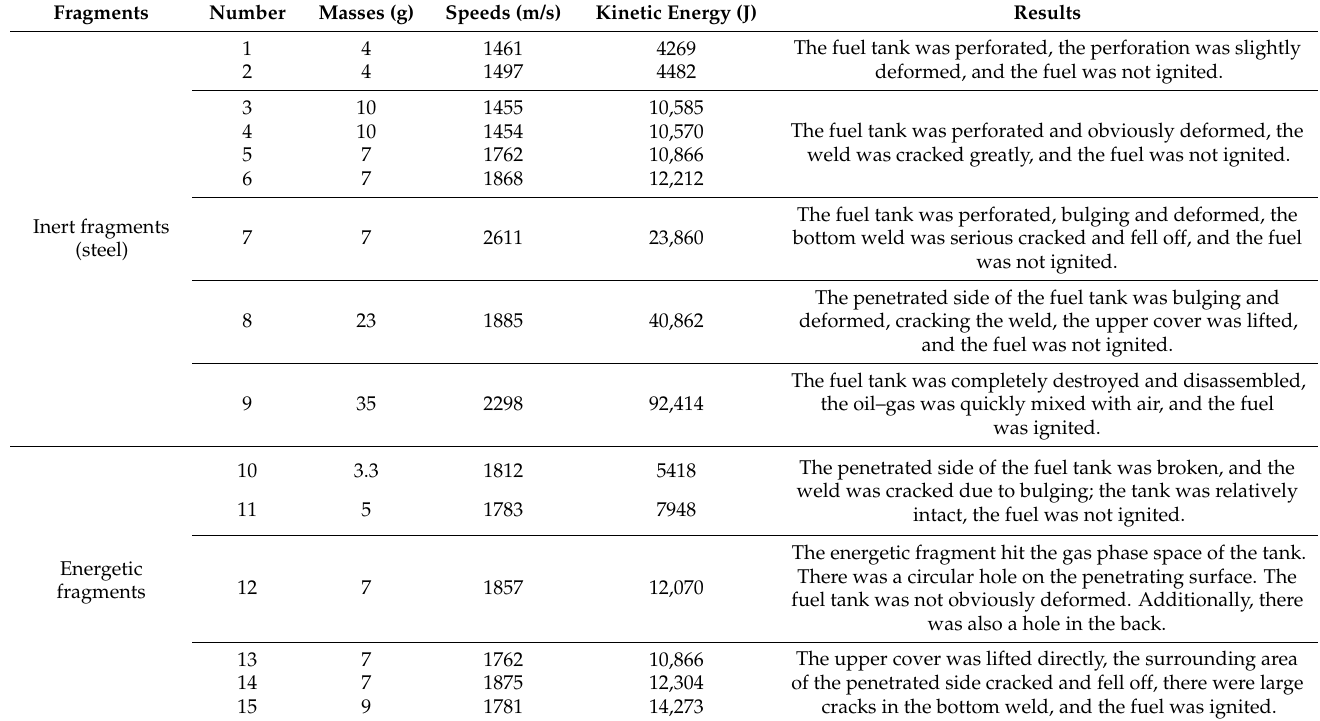
Table 2. Experimental